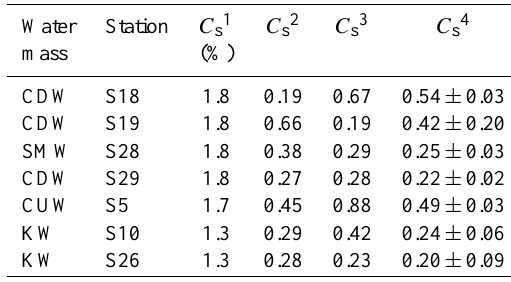
Table 2. Organic content ( C s , %) in the surface sediments in the